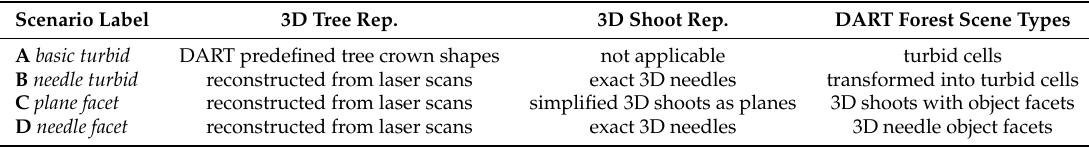
Table 3. Four scenarios representing varying structural complexity of a virtual Norway spruce forest scene used to simulate canopy reflectance in the DART model. Scenario Label 3D Tree Rep. 3D Shoot Rep. A basic